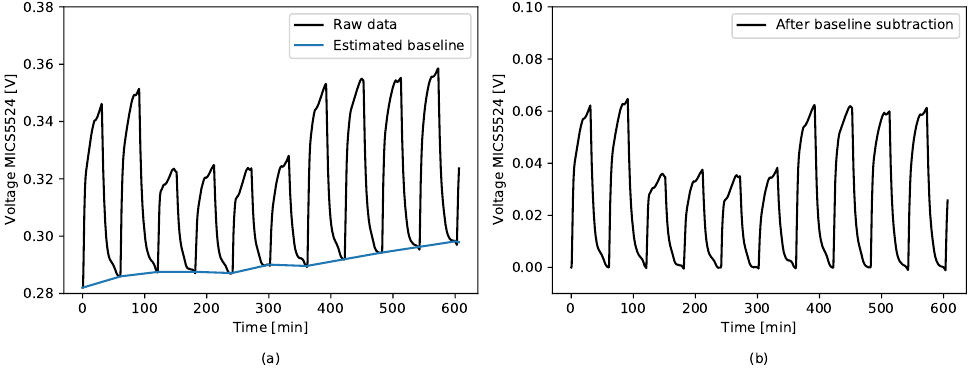
Figure 4. Result of the long-term test for different gas mixtures—MICS5524.